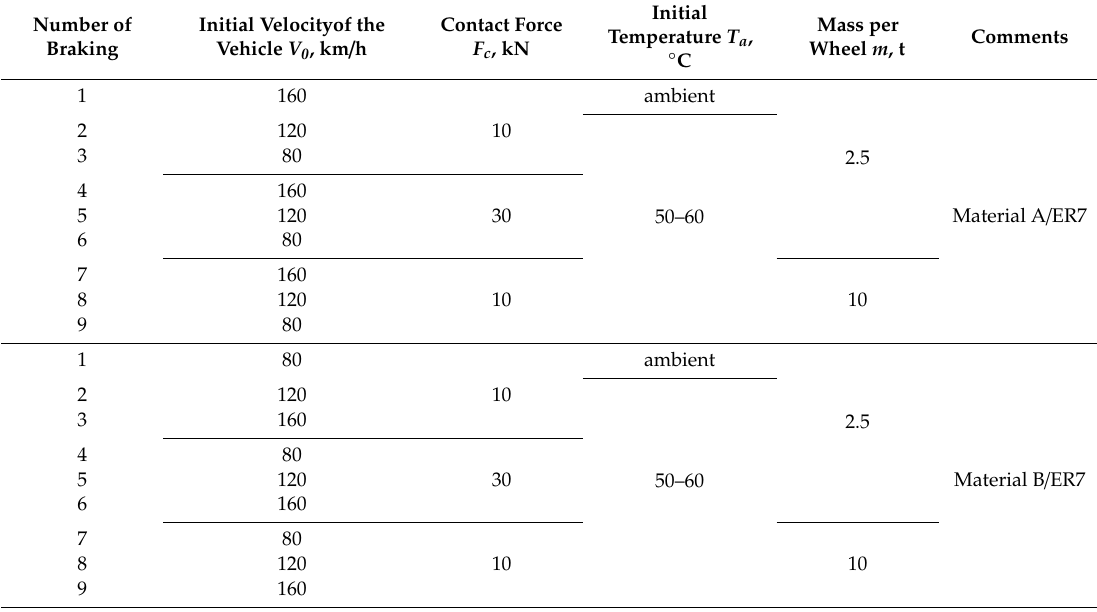
Table 3. Full-scale dynamometer test program for 1xBg configuration.